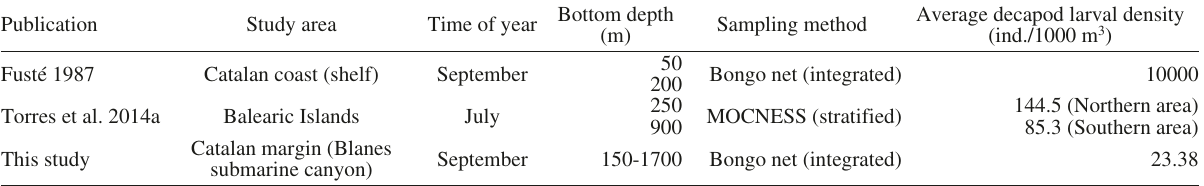
Table 5. – Comparison of up-to-date studies on decapod larval communities in the western Mediterranean